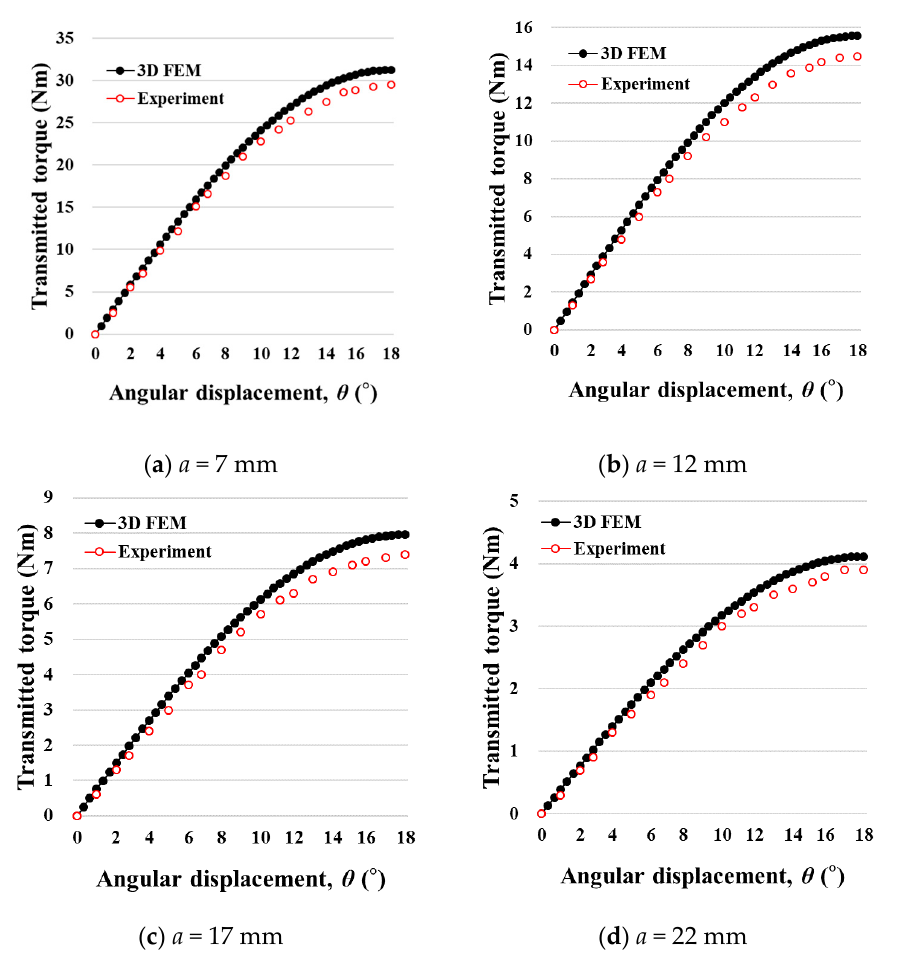
Figure 16. The static performance of the magnetic couplings with different air-gap lengths from the three-dimensional finite-element method (3D FEM) and experimental tests.